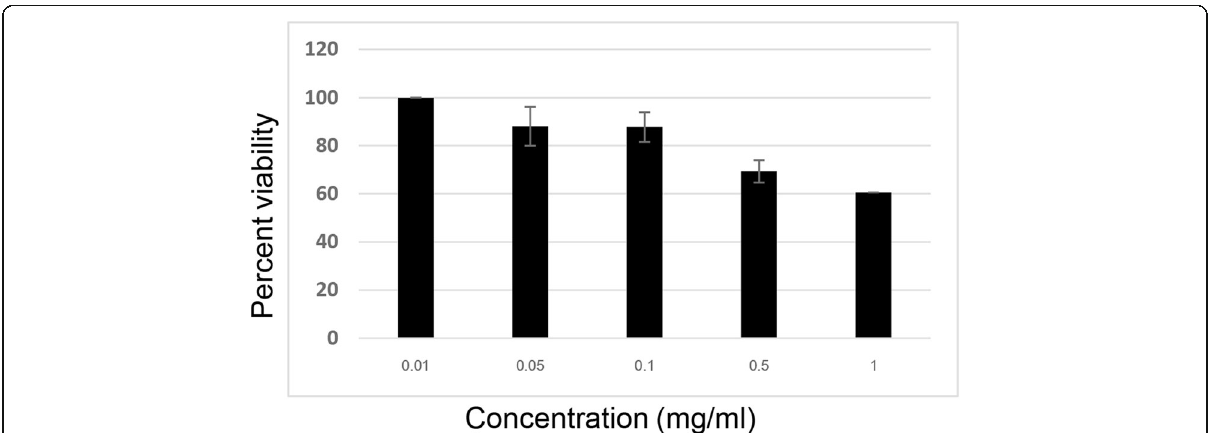
Fig. 4 Effect of simvastatin on the viability of HepG2 cells assessed by the MTT assay: Cells were treated with standard concentrations (0.01, 0.05, 0.1, 0.5 and 1 mg/ml) of simvastatin for 24 h. The results are expressed as the mean ± SD from three independent experiments. DMSO (0.5%) was used as the negative